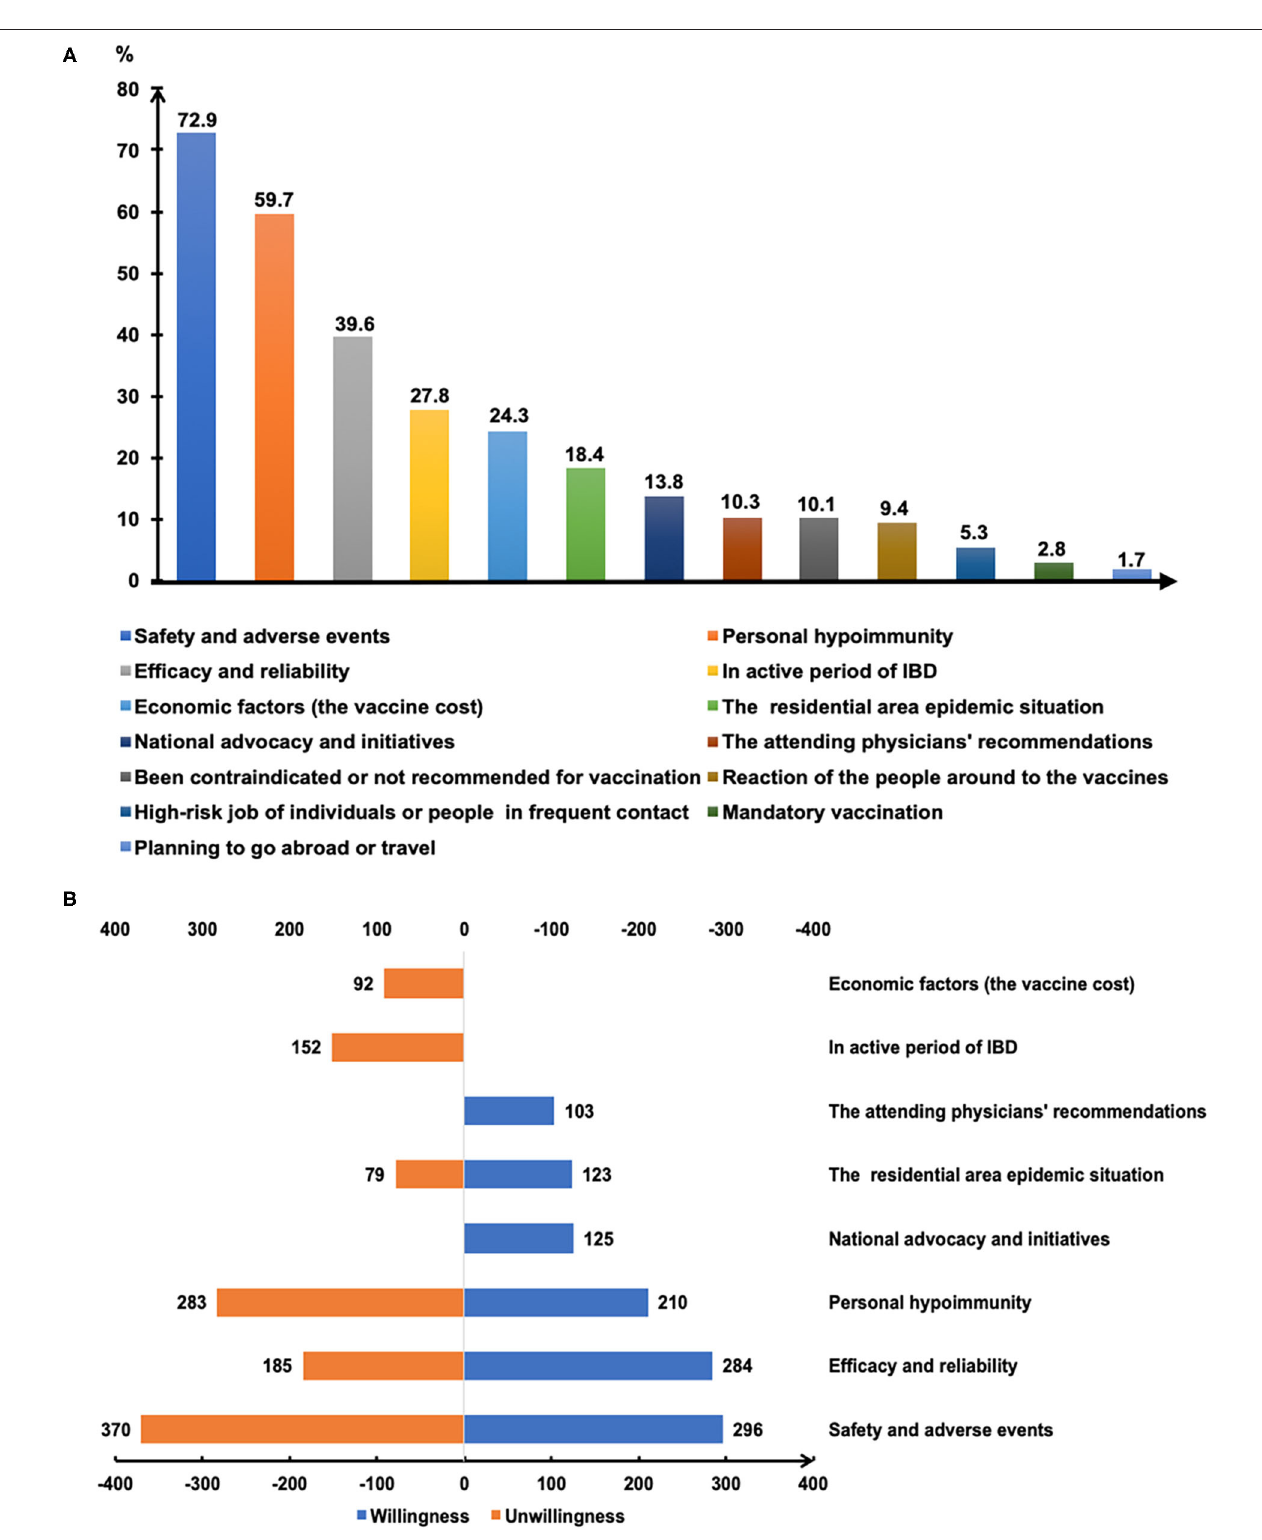
FIGURE 3 | The reasons affecting COVID-19 vaccination of patients with IBD (A) . The main reasons for getting or not getting COVID-19 vaccinated (B) .